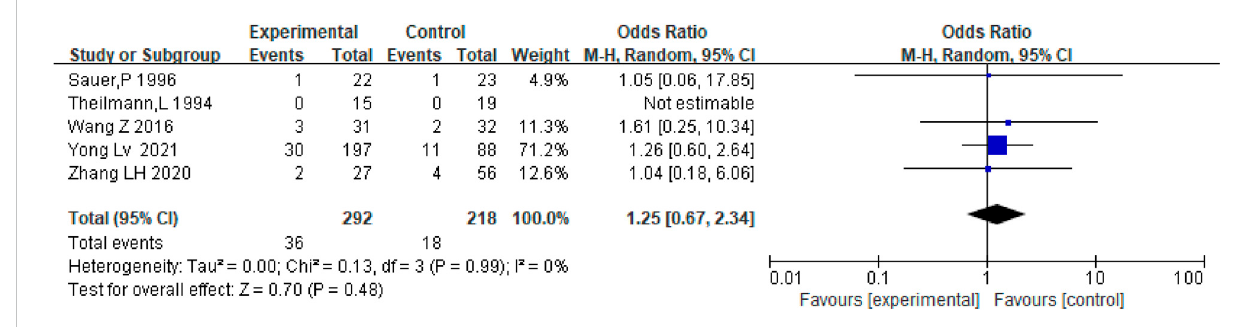
FIGURE 8 Effect of anticoagulation or antiplatelet treatment on bleeding after TIPS.